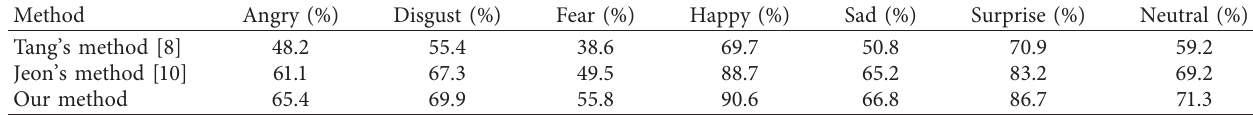
Table 2: Classification accuracy of facial expression in different methods.